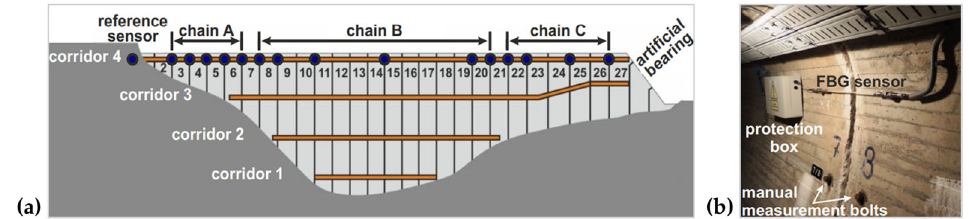
Figure 8. SHM within the hydro power dam using quasi-distributed FBG sensor. ( a ) Layout scheme; ( b ) one of the installed FBG sensors within the maintenance corridors of the dam. Reprinted with permission from [134].